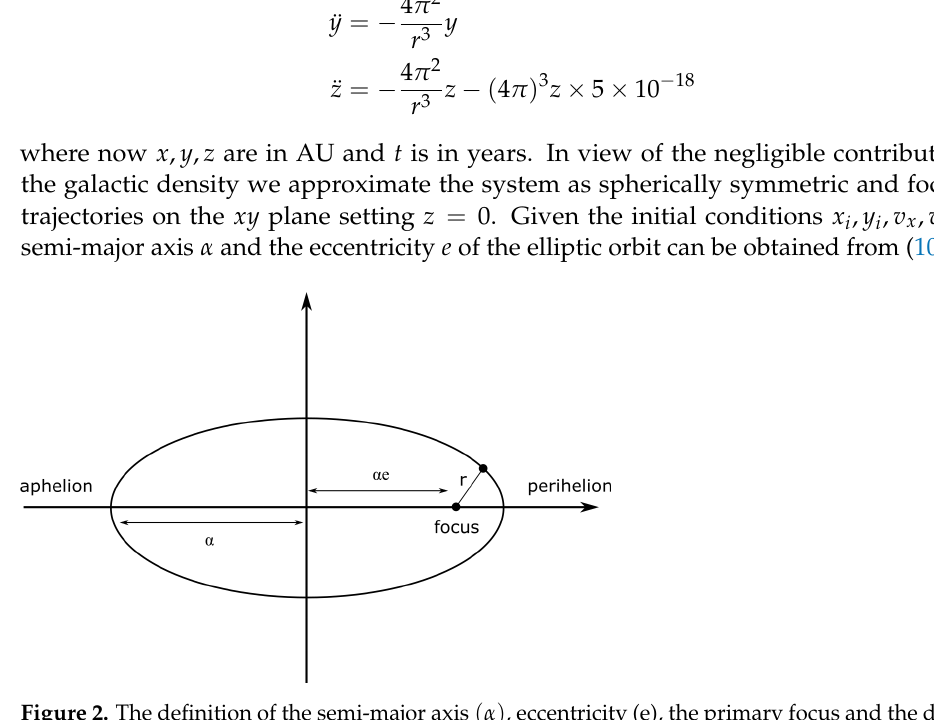
Figure 2. The definition of the semi-major axis ( α ) , eccentricity (e), the primary focus and the distance from the primary focus (r) of an